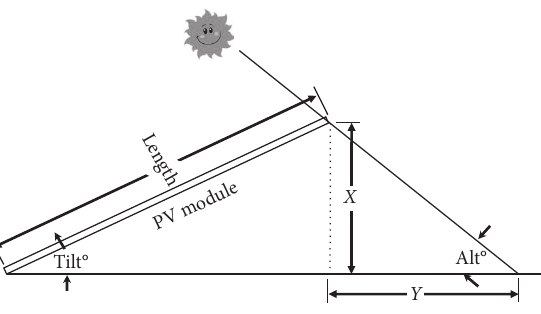
Figure 6: Direction of PV solar panel under the sun.